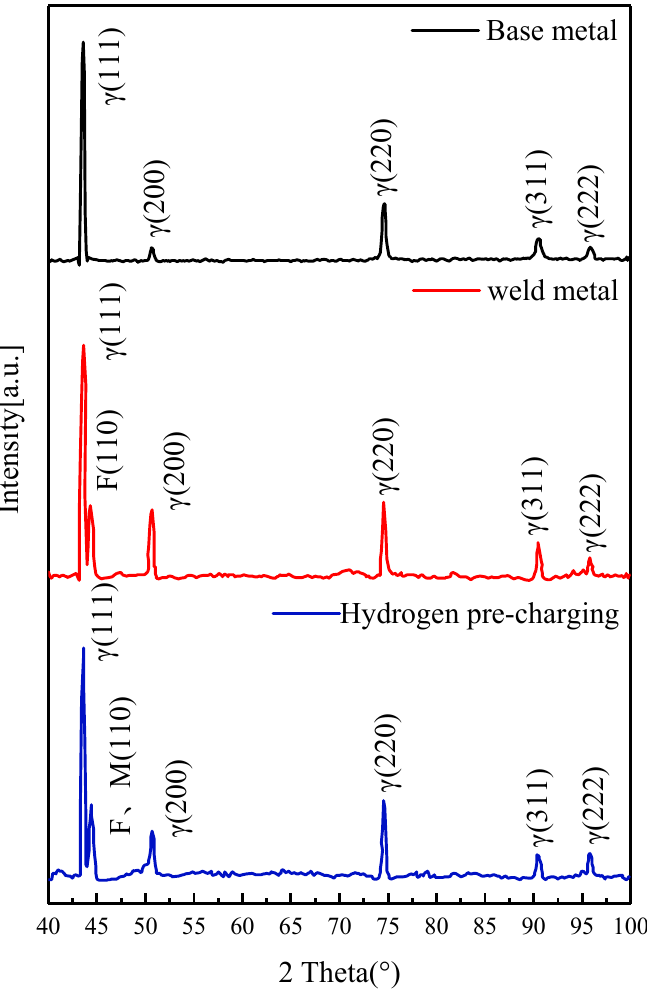
Figure 6. XRD patterns of base metal and TIG weld